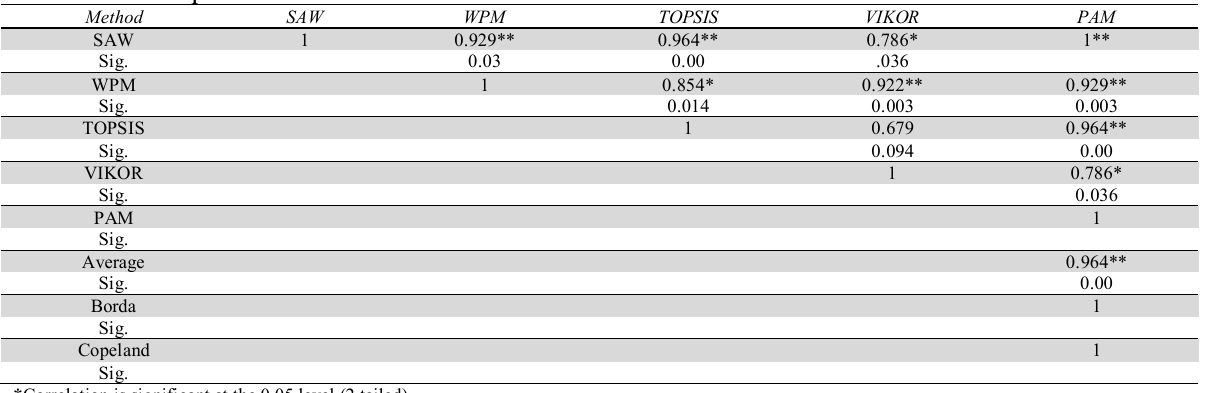
The results of Spearman’s rank correlation coefficients